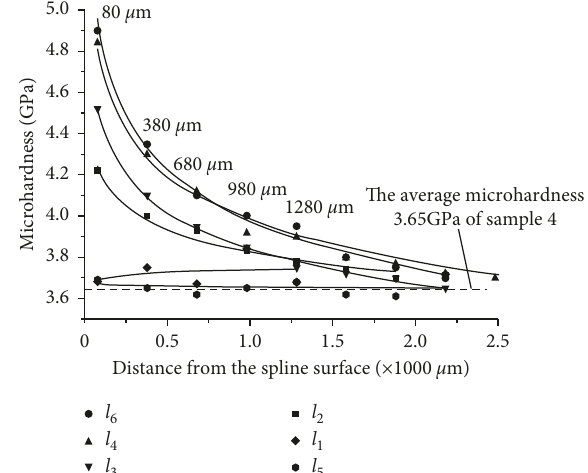
Figure 3: Microhardness of the spline tooth surface as the function of